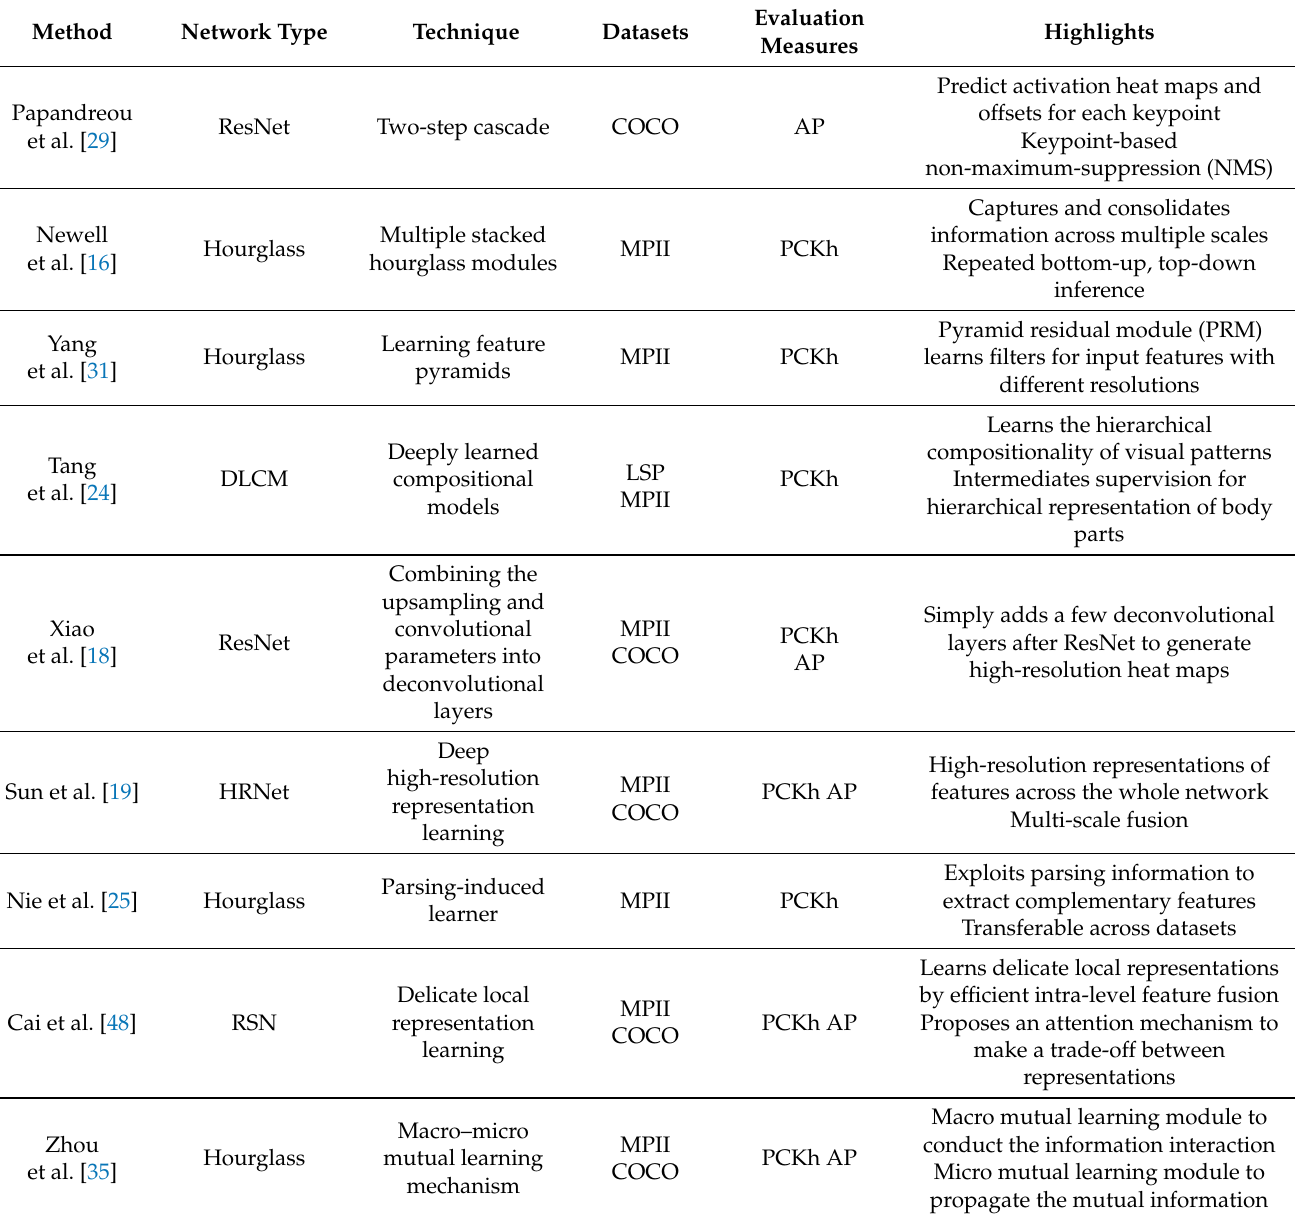
Table 1. Summary of 2D human pose estimation